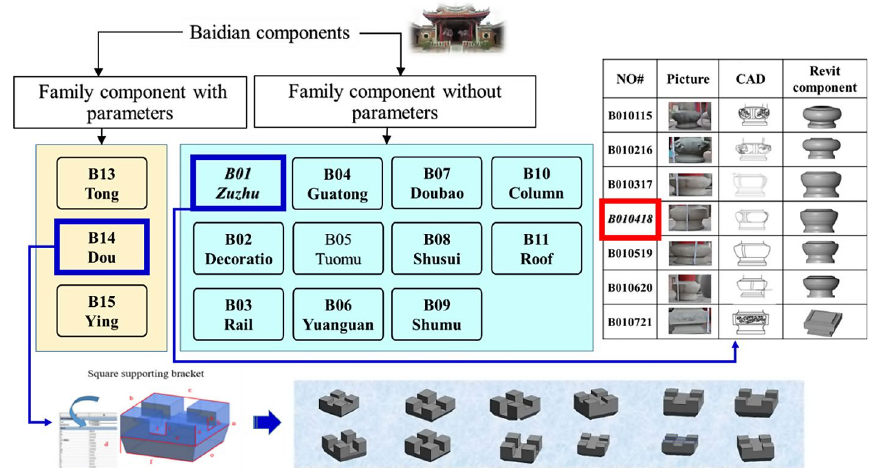
Figure 5. Types of components in hall of worship